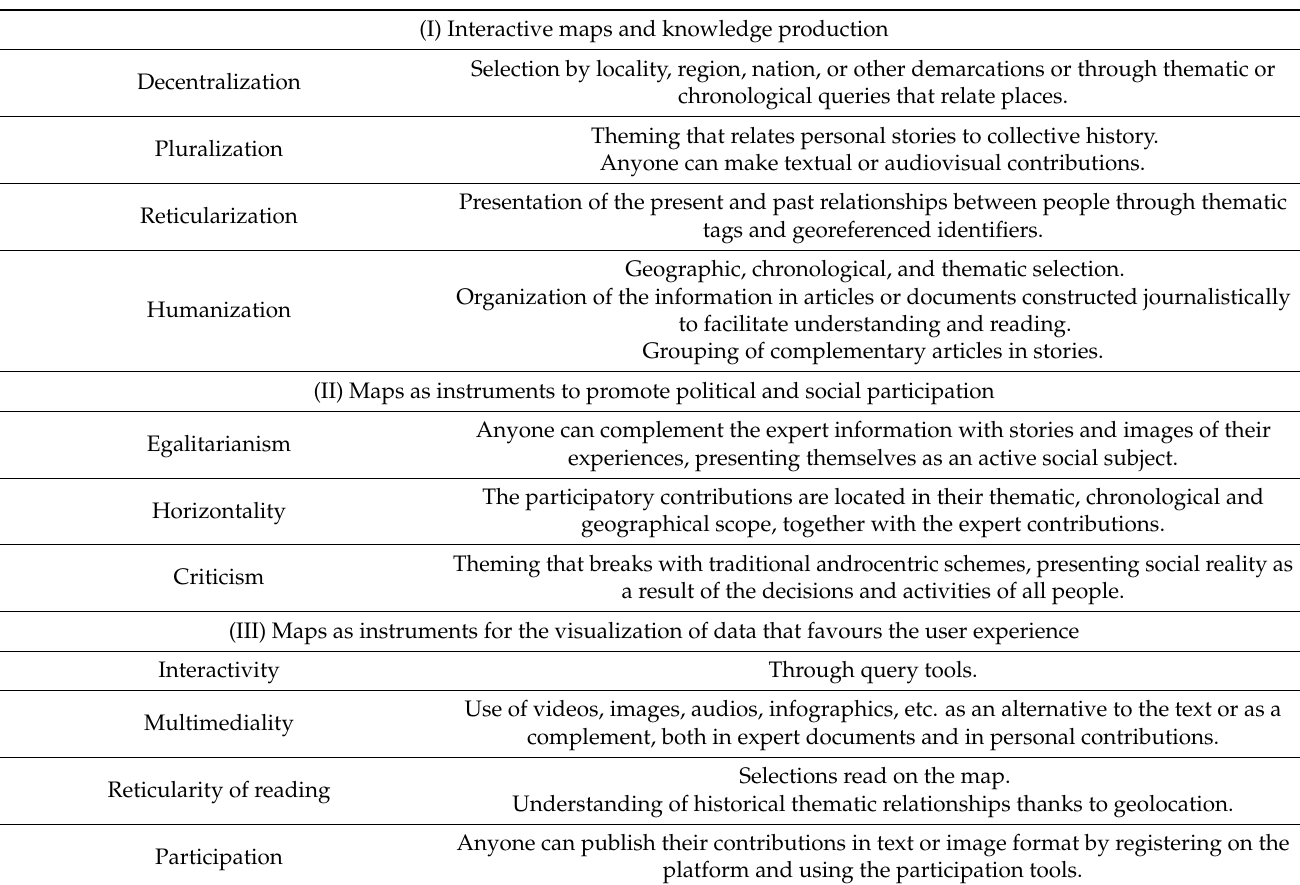
Table 3. Characteristics of the Ciutadania Plural